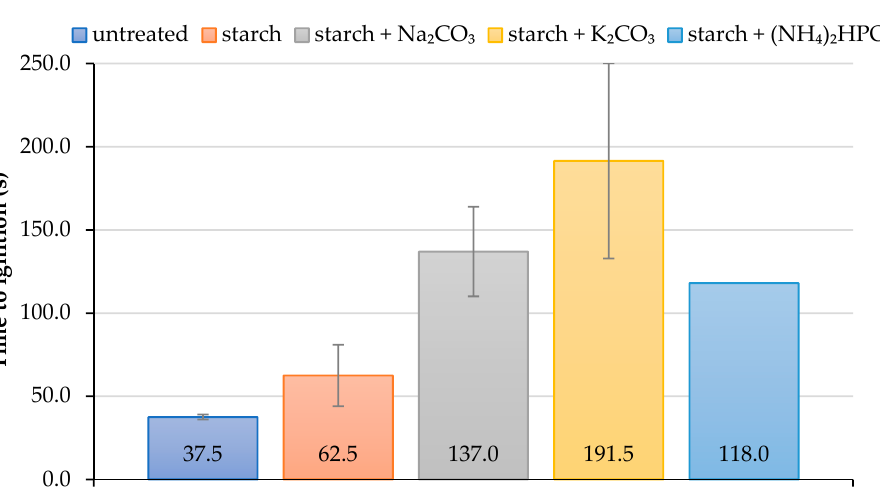
Figure 3. The average values of time to ignition for unprotected and protected wood samples.